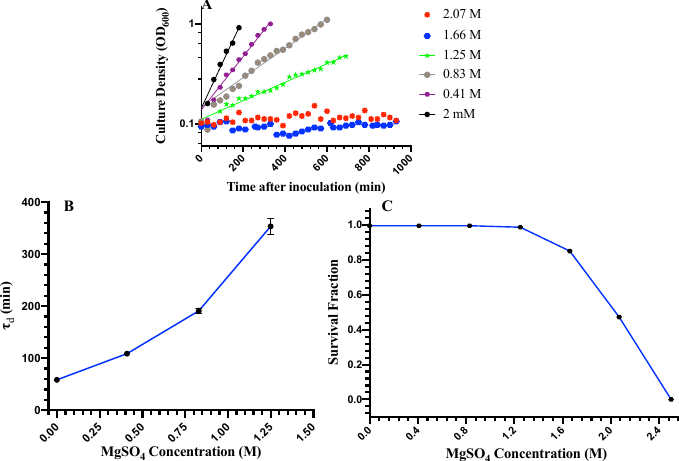
Figure 1. Growth and death of E. coli at different MgSO 4 concentrations. ( A ) Growth curves of bacteria at different concentrations of magnesium sulfate. ( B ) The population double time, τ d , as a function of magnesium sulfate concentration. Population doubling time increases with increasing concentration of magnesium sulfate. Since cells do not exhibit any growth for salt concentrations greater than 1.25 M but undergo cell death, we do not measure the population doubling time for these concentrations. ( C ) The survival fraction of cells as a function of magnesium sulfate concentration. Survival fraction does not change for concentrations lower than 1.25 M. Beyond this salt concentration, the survival fraction drops